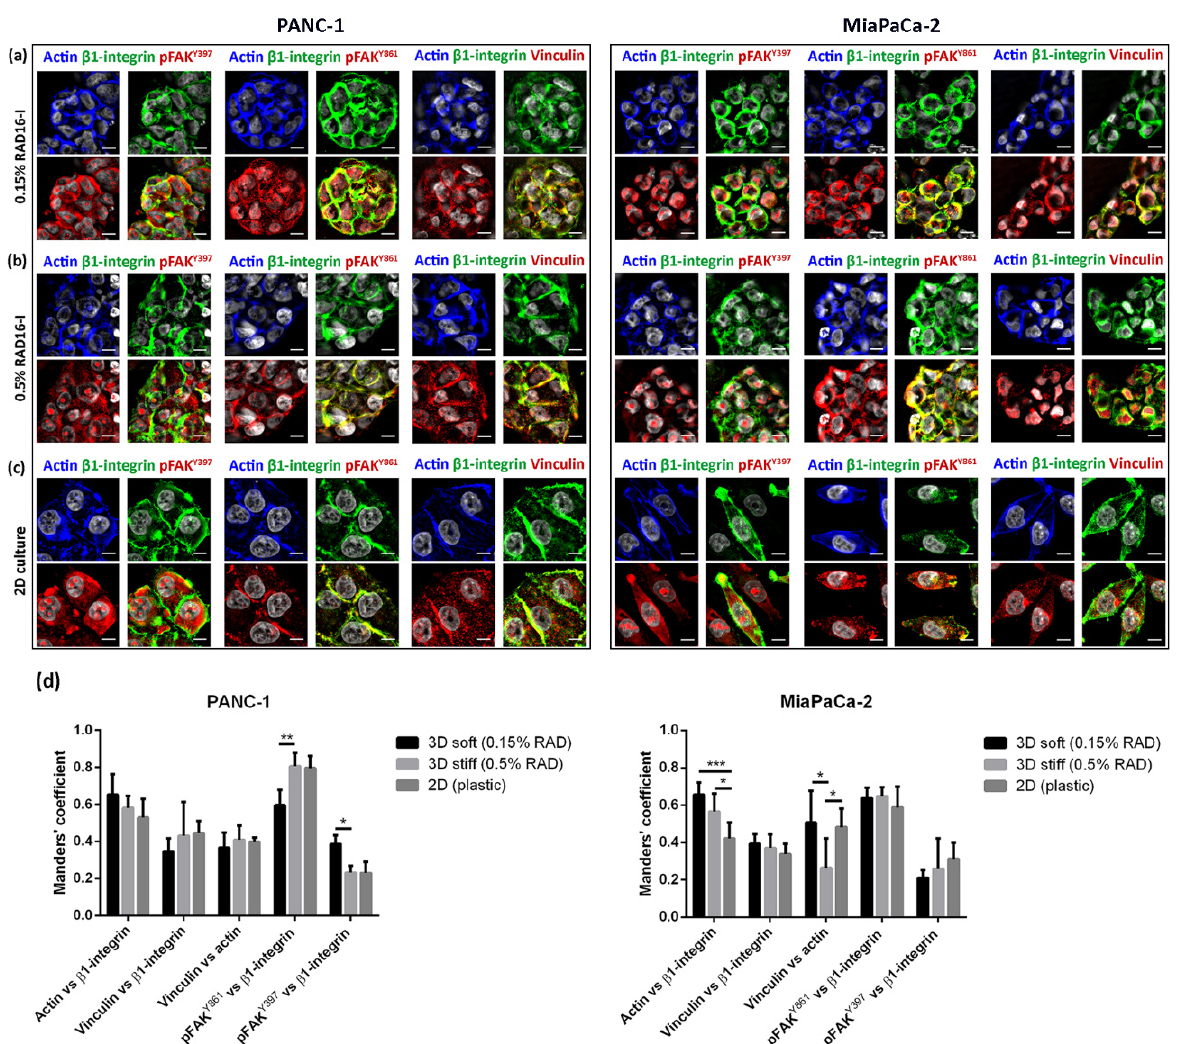
Figure 3. Immunofluorescence analysis of signal mechanotransduction proteins. Actin (blue) β 1- integrin (green), pFAK Y397 (red), pFAK Y861 (red) and vinculin (red) staining in PANC-1 (left) and MiaPaCa-2 (right) cells in ( a ) 0.15% RAD16-I; ( b ) 0.5% RAD16-I and ( c ) 2D cultures. Merge of green and red channels is also shown. Scale bars represent 10 µm; ( d ) Mander’s colocalization coefficients of PANC-1 and MiaPaCa-2 cells (n = 5). Statistical differences are indicated as * for p value < 0.05, ** for p value < 0.01 and *** for p value < 0.001.